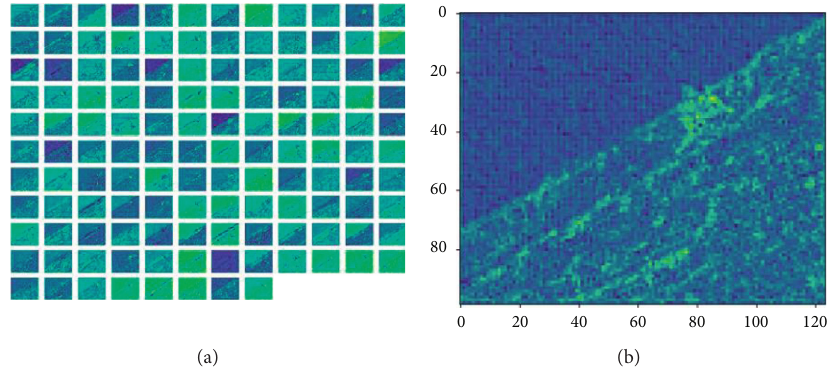
Figure 4: The visualization of ResNet-50. (a) After 50 layers of convolution. (b) Fusion by 1:1 ratio.